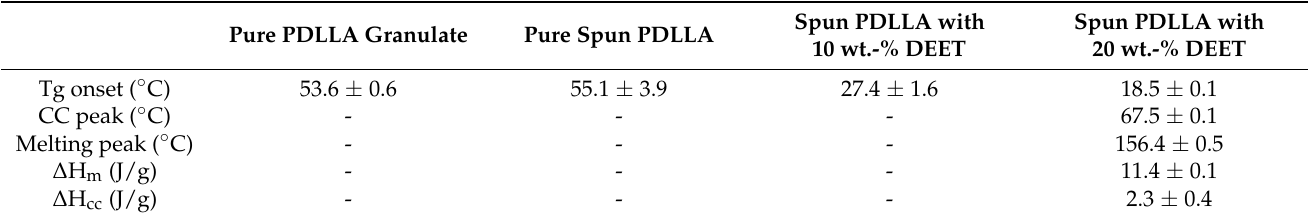
Table 2. Summary of thermal events for pure PDLLA granulate and PDLLA monofilaments with varying DEET content. Pure PDLLA